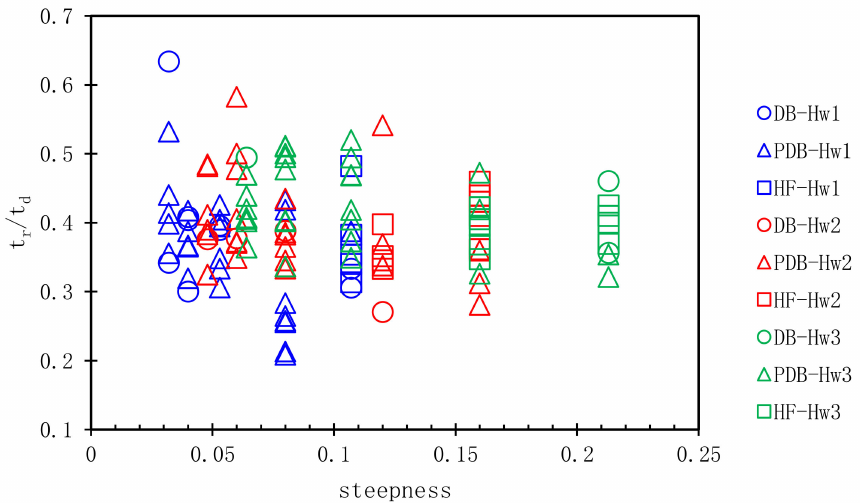
Figure 10. Effect of wave steepness ( ε = H w /L w ) on the t r /t d ratio ( t r and t d are rise and event duration times, respectively) for all the events of the 15 study